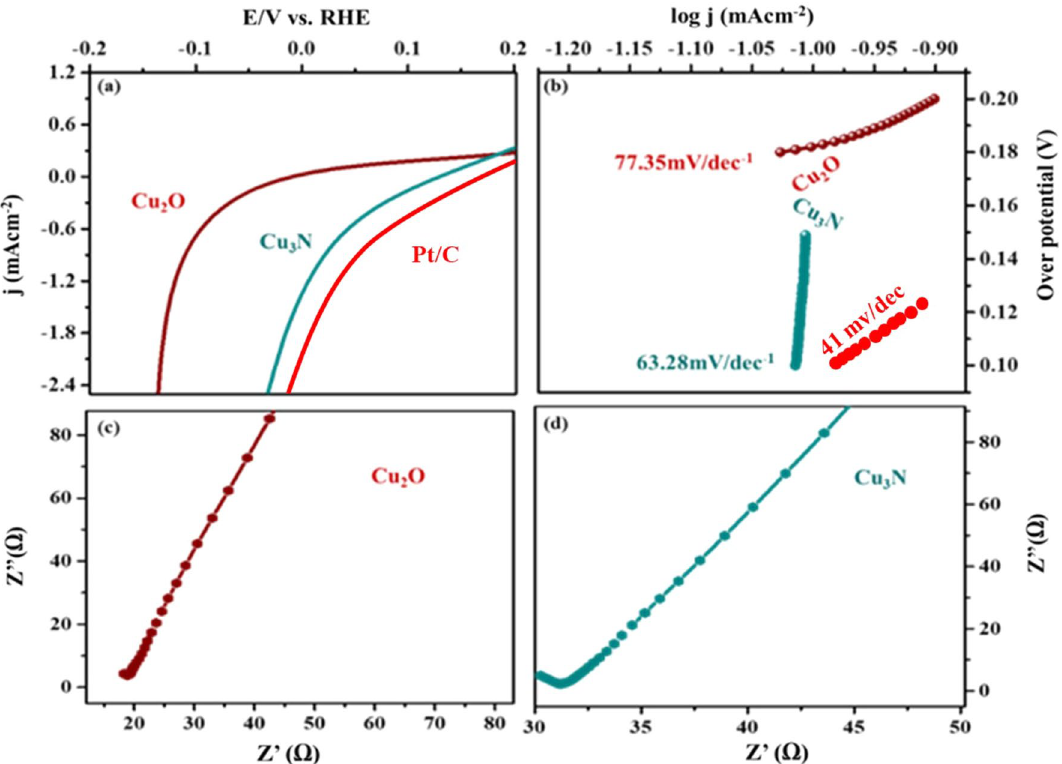
Figure 12. ( a ) Steady state polarization plot of Cu 3 N (synthesized at 160 ml/min ammonia flow rate and 300 °C), Cu 2 O and Pt/C. ( b ) Tafel plot in 1 M NaOH ( c,d ) Electrochemical Impedance spectroscopy ( c ) Cu 2 O, ( d ) Cu 3 N (synthesized at 160 ml/min ammonia flow rate and 300